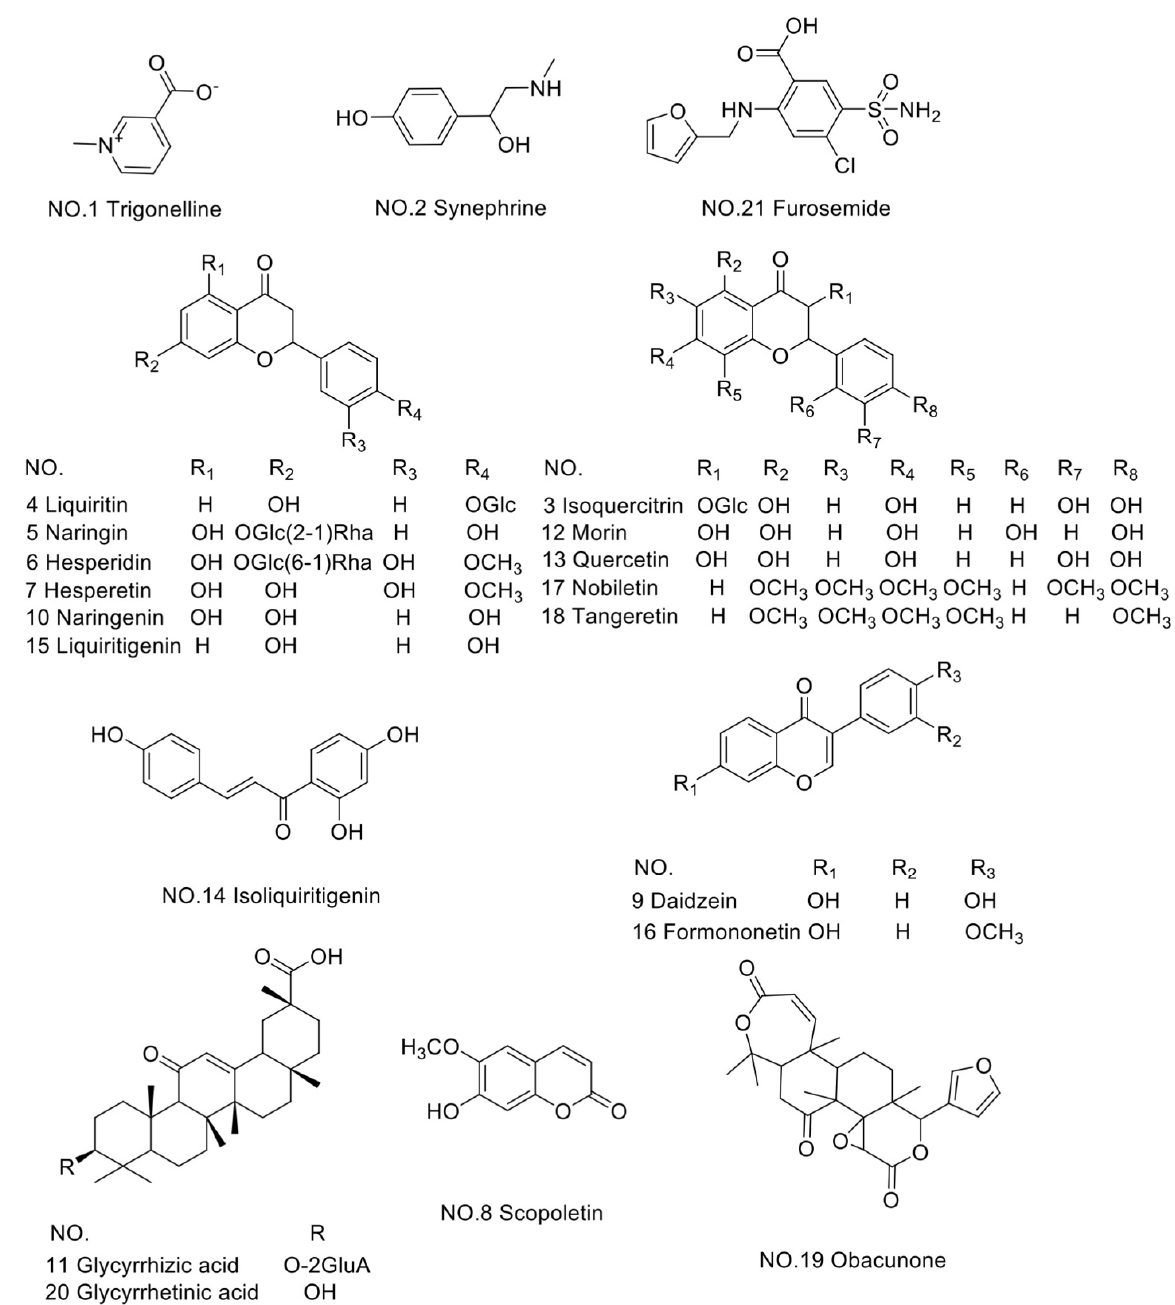
Figure 1. Structures of 20 chemicals analyzed in WDD and IS.